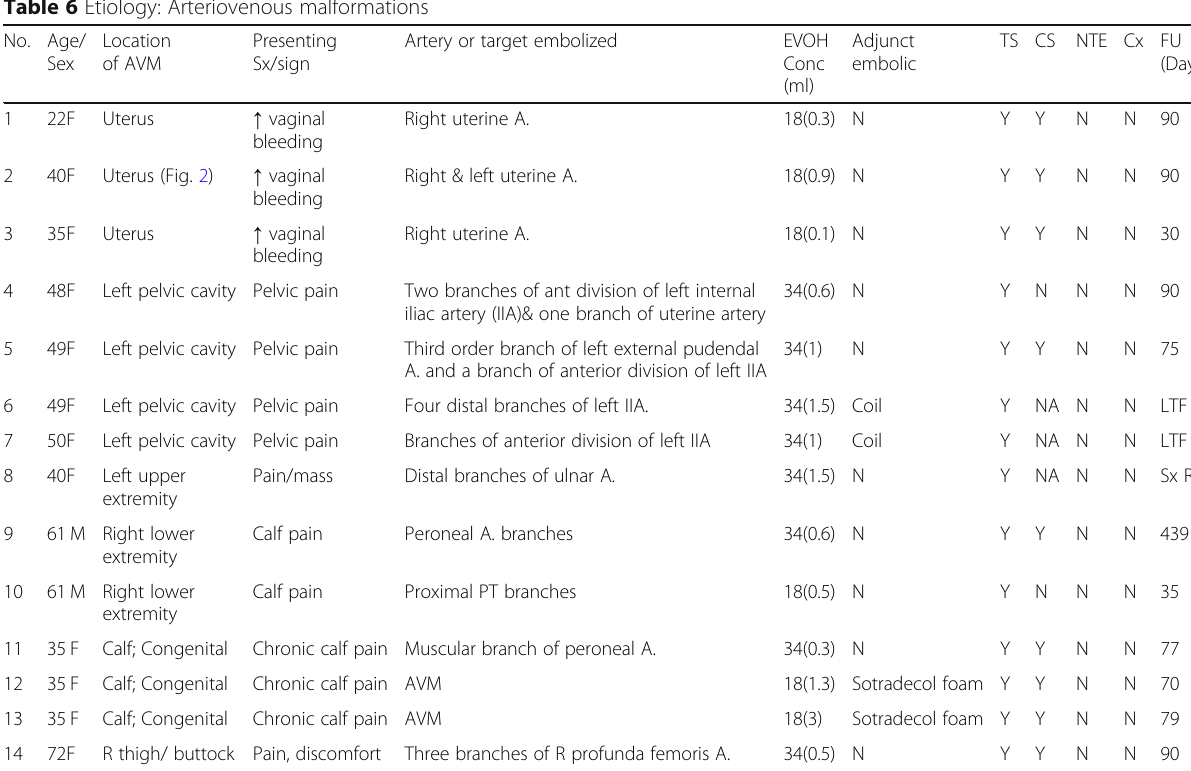
Table 6 Etiology: Arteriovenous